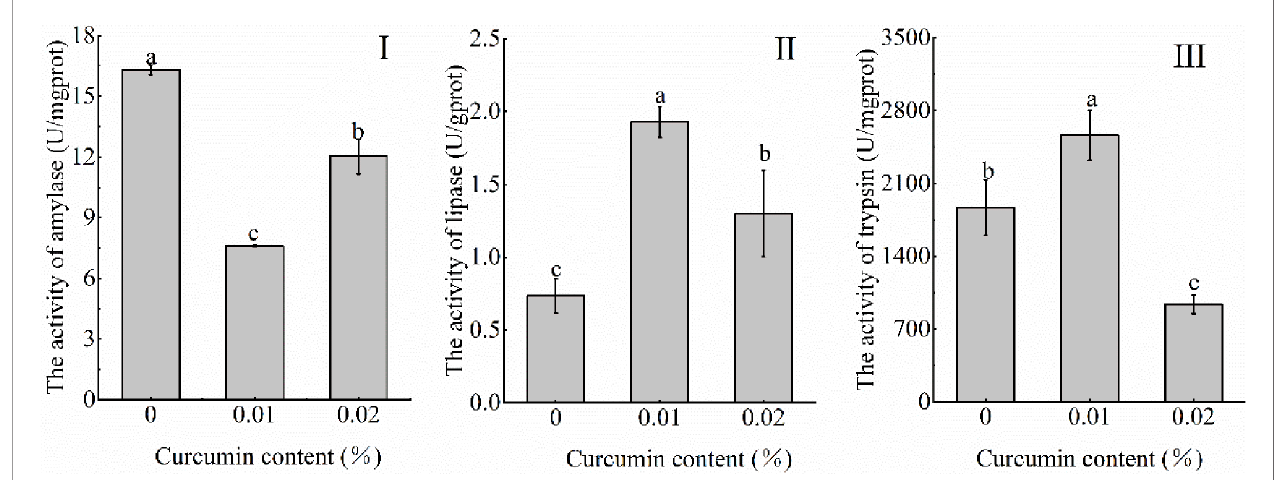
FIGURE 1 | Effects of different levels of curcumin on the activities of intestinal digestive enzymes (I, amylase activity; II, lipase activity; III, trypsin activity). Different superscript letters indicate signi fi cant differences among treatments (P < 0.05).